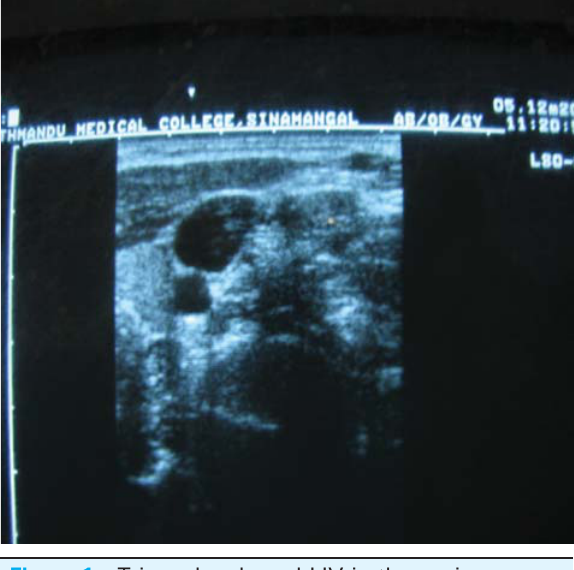
Figure 1. Triangular-shaped IJV in the supine